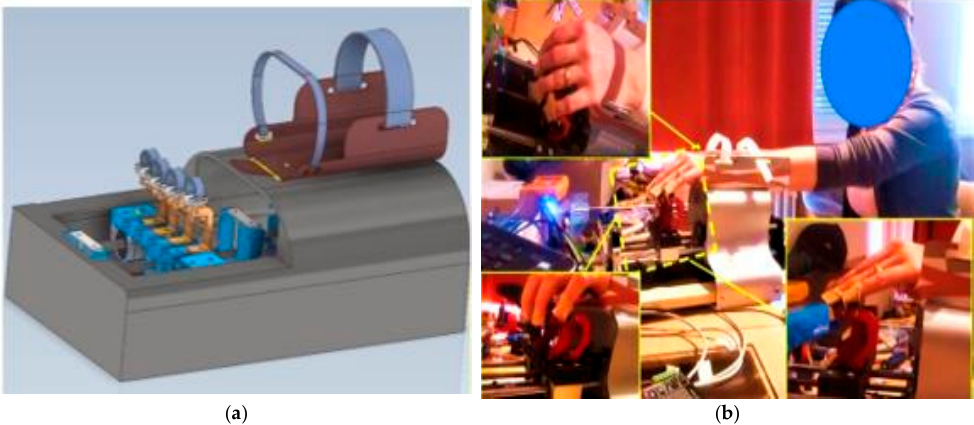
Figure 2. A general overview of the proposed FWRMS prototype, ( a ) 3D structure overview of the FWRMS prototype; ( b ) real healthy object’s hand integration with the proposed system.